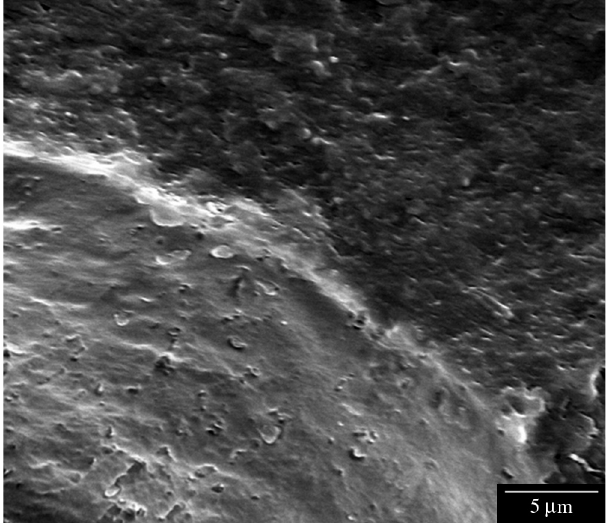
Figure 2. SEM micrograph of the cryofractured surface of a injection molded P(3HB) specimen.